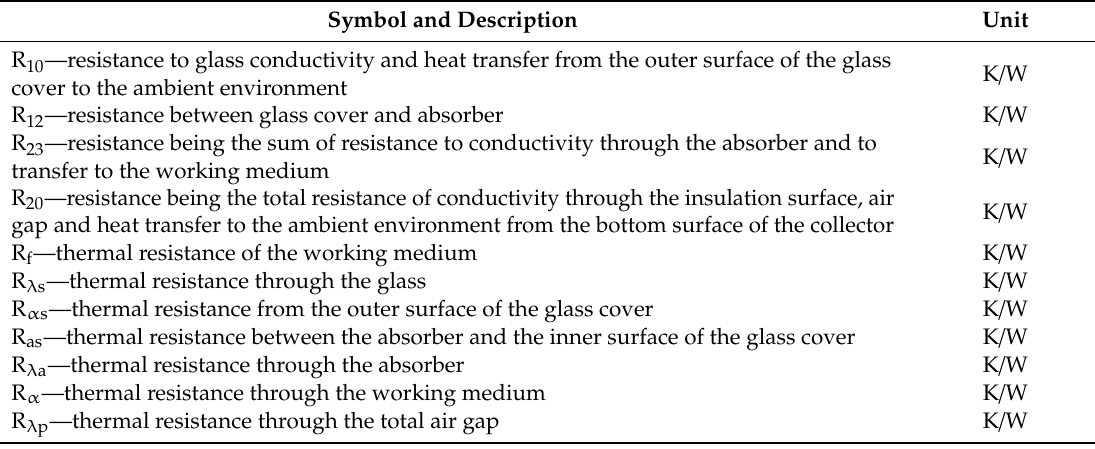
Table A1. Description of resistances and heat capacities of a modeled flat-plate solar collector. Symbol and